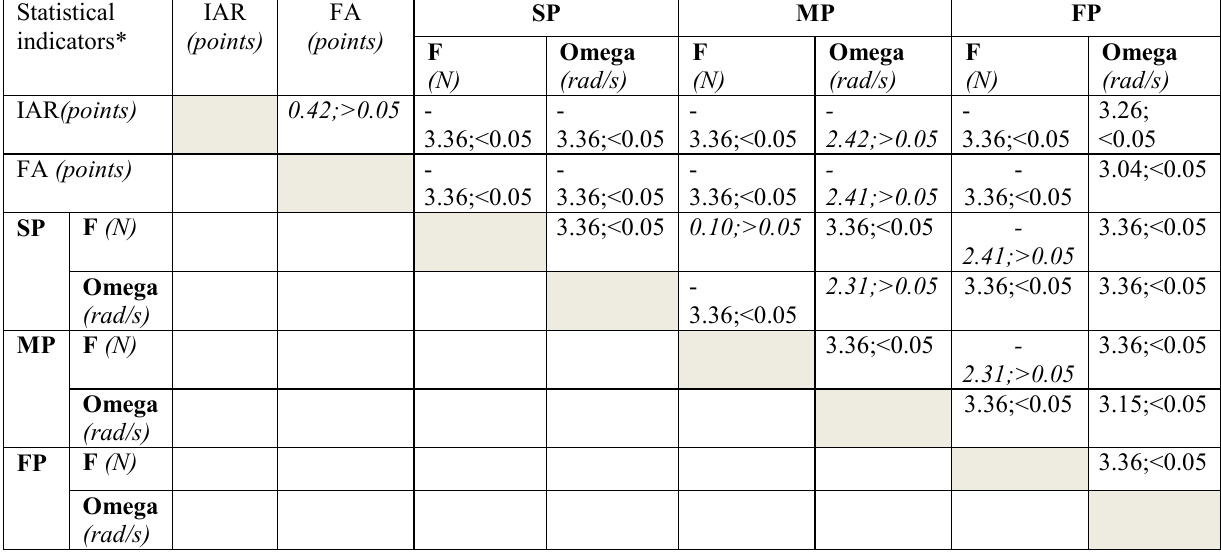
Degree of connection of indicators of kinematic and dynamic key elements; structures of dismounts from BB, fulfilled